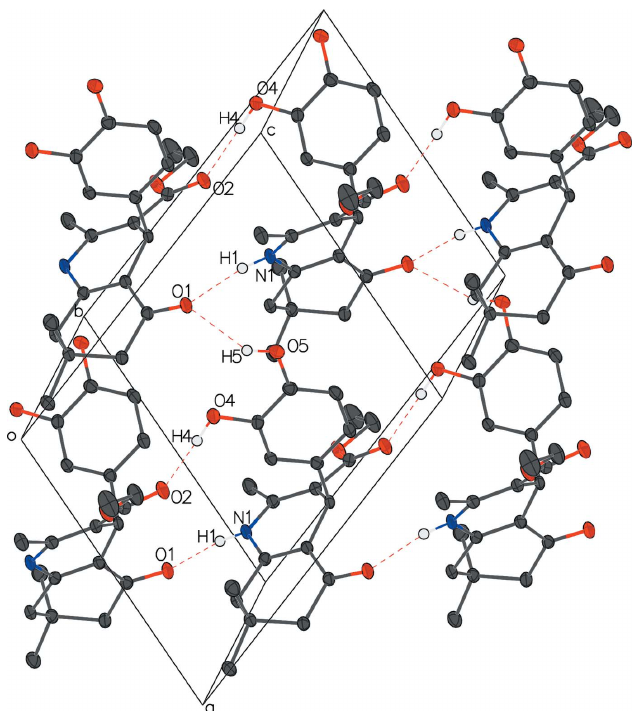
Figure 6 The packing of title compound III . Intermolecular hydrogen bonds (shown in dashed lines) cross link the molecules to form a sheet parallel to the (010) plane. H atoms not involved in these hydrogen bonds are removed for clarity.